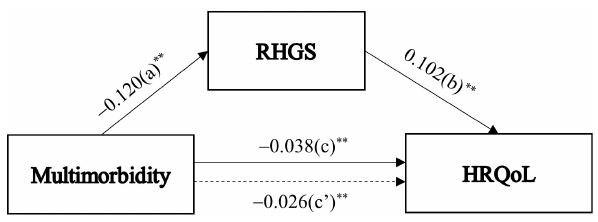
Fig. 2. A mediation analysis for the relationship of multimor- bidity and relative handgrip strength (RHGS) with health- related quality of life (HRQoL). ∗∗ p <